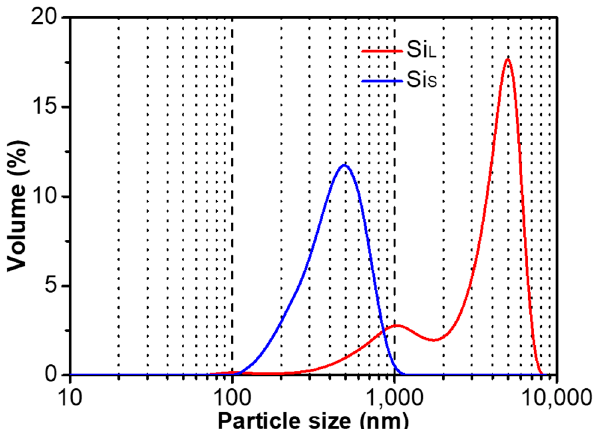
Figure 4. Particle size distribution of Si L and Si S .